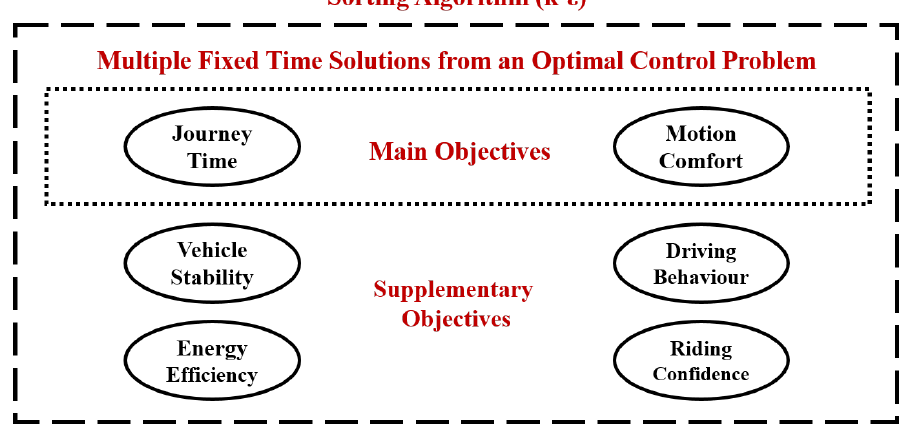
Figure 4. The combination of OCP and k − (cid:101) algorithm to identify the optimum velocity profile among multiple